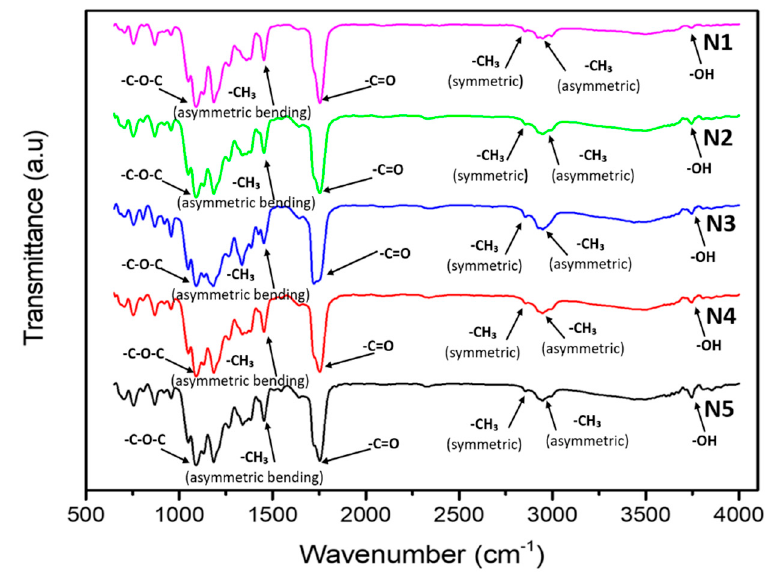
Figure 5. FTIR of PLA-PBS, PLA-PBS-CNC nanocomposite films.